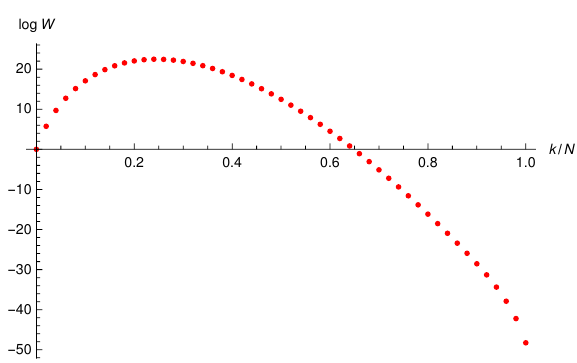
Figure 12. Plot of log W A in the ungapped phase ( g = 0 : 5 ; N = 100). We do not have a symmetry k k $ N (cid:0) k in the U( N ) theory.